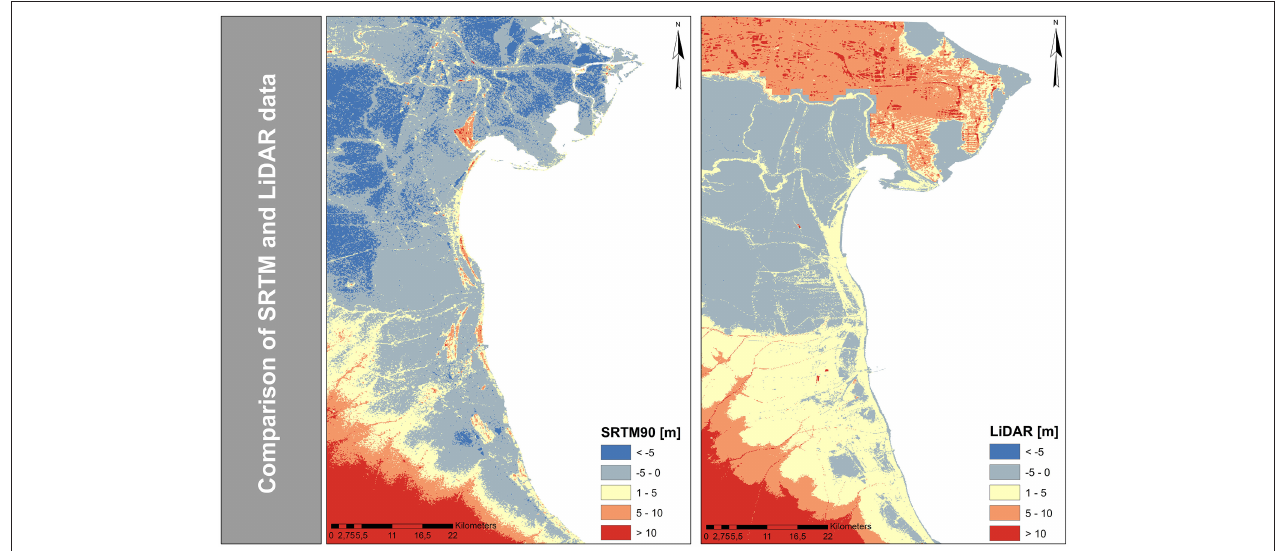
FIGURE 8 | Comparison of the SRTM90 and LiDAR digital elevation data for the Emilia-Romagna region.